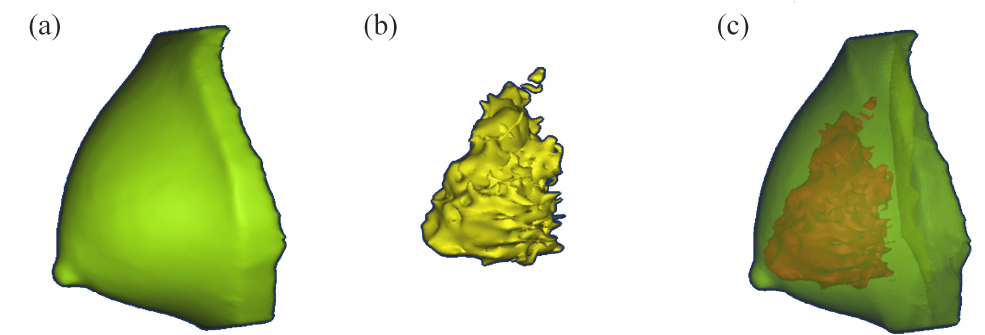
Figure 1. CAD model of a breast including ( a ) the contour of the breast, ( b ) the glandular tissue, and ( c ) the distribution of glandular tissue in the breast. Breast volume, glandular volume, and VBD are 286.8 cm 3 , 54.0 cm 3 , and 18.9%, respectively.